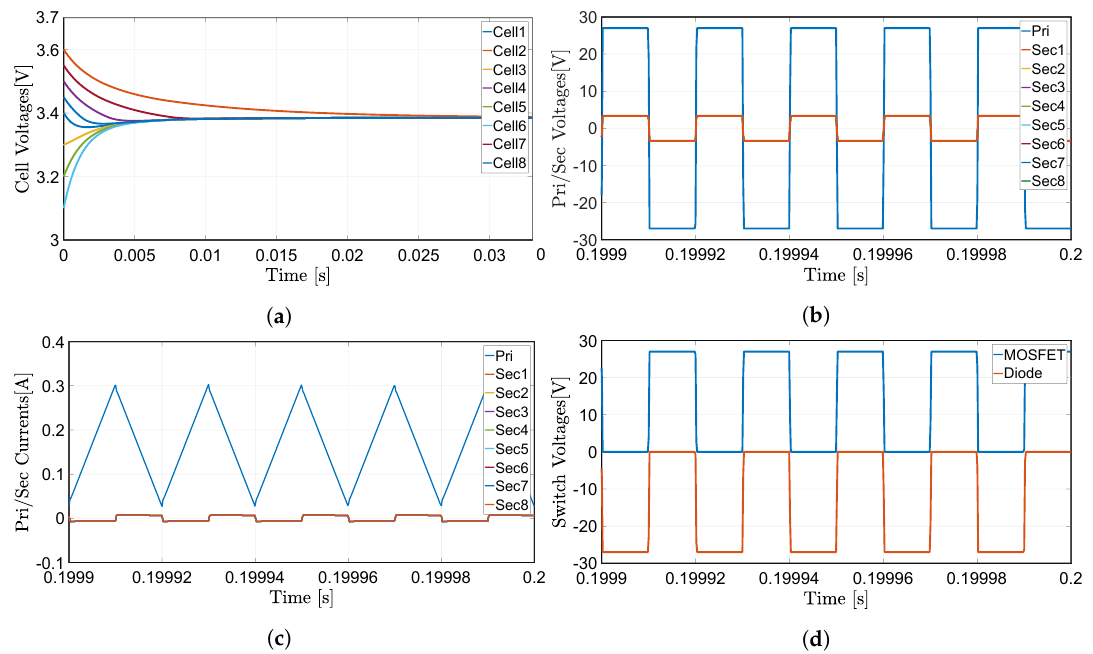
Figure 3. ( a ) Cell voltages vs. time of the circuit; ( b ) primary/secondary voltages vs. time; ( c ) primary current vs. time of the circuit in the steady state; ( d ) MOSFET and diode voltages vs. time in the steady